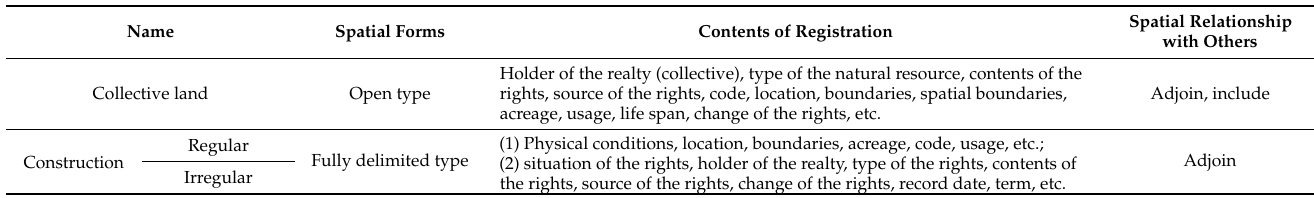
Table 3. Objects in the NRUM.